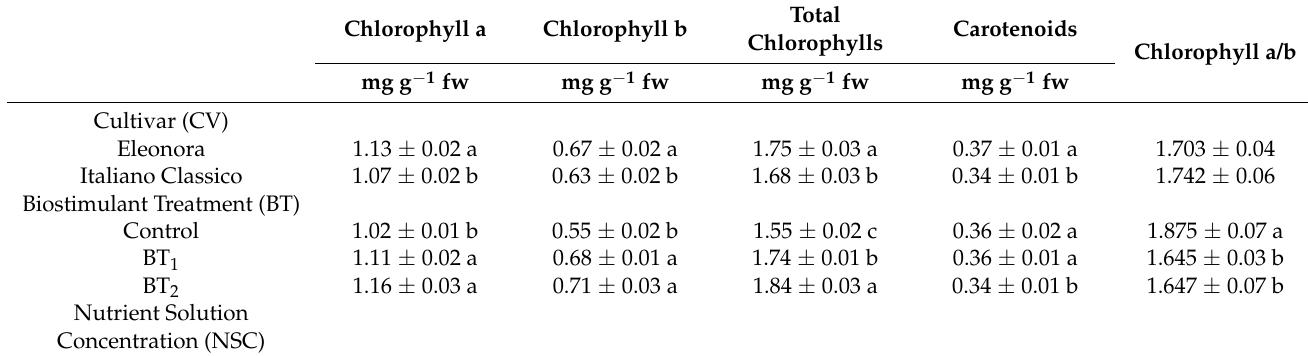
Table 4. Analysis of variance and mean comparisons for pigments concentration of Eleonora and Italiano Classico basil cultivars grown in floating raft system under two different nutrient solutions treatments and two rates of biostimulant